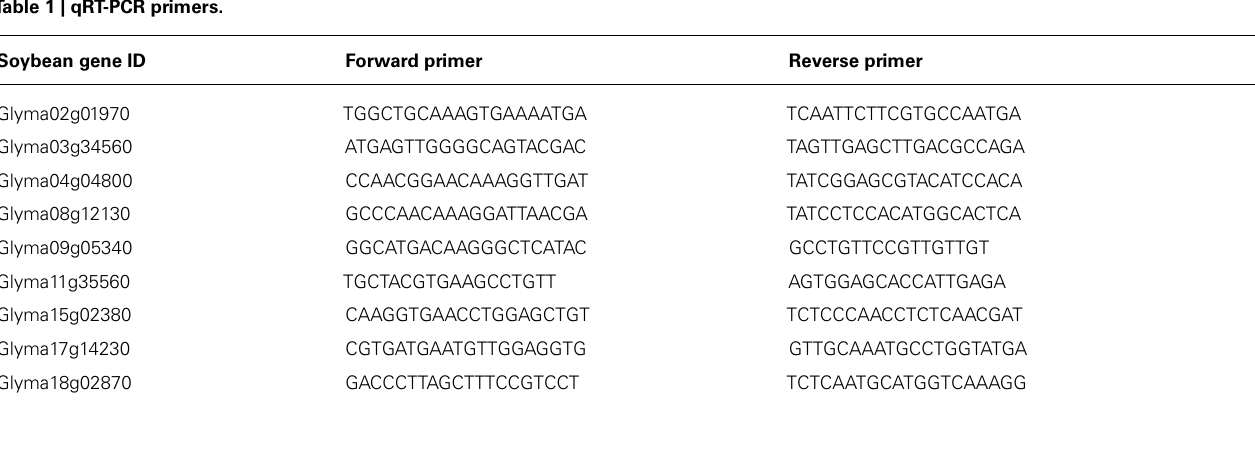
(B) GUS -stained soybean root system, the black arrows point at the transgenic root and the white arrows point at the non-transgenic root; (C) GUS -stained transgenic root hair cells. Bar = 200 μ m.